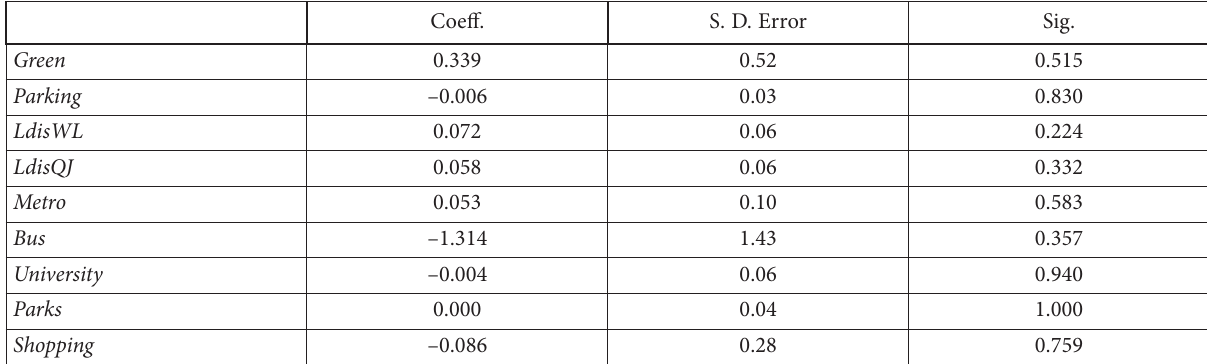
Table 4. Density continuity test of control